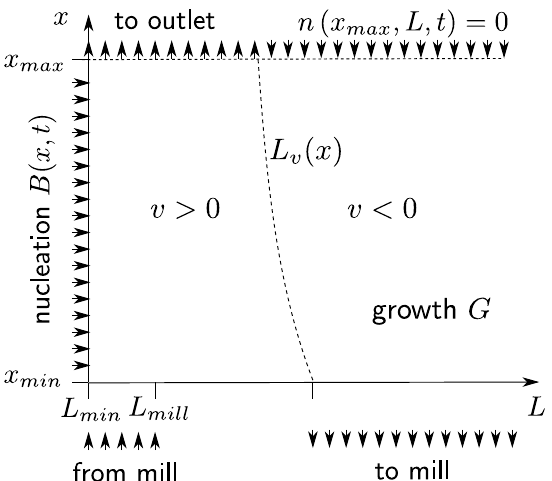
Figure 2. Computation domain of the model. Arrows at the boundaries indicate if crystals enter or leave the domain. The dashed line represents the crystal size L v , where crystals are in mechanical equilibrium and do not